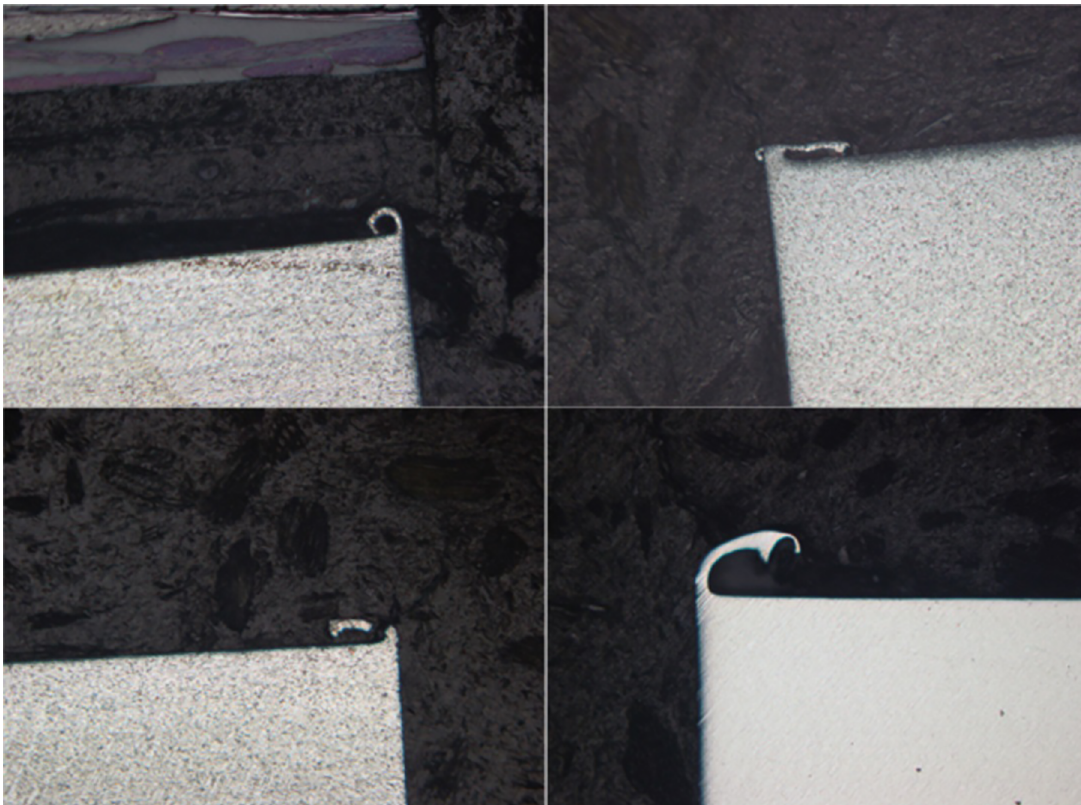
Figure 12. Burrs on sample pieces 17 (a), 24 (c), 27 (b) and 32 (d). Images obtained through optical